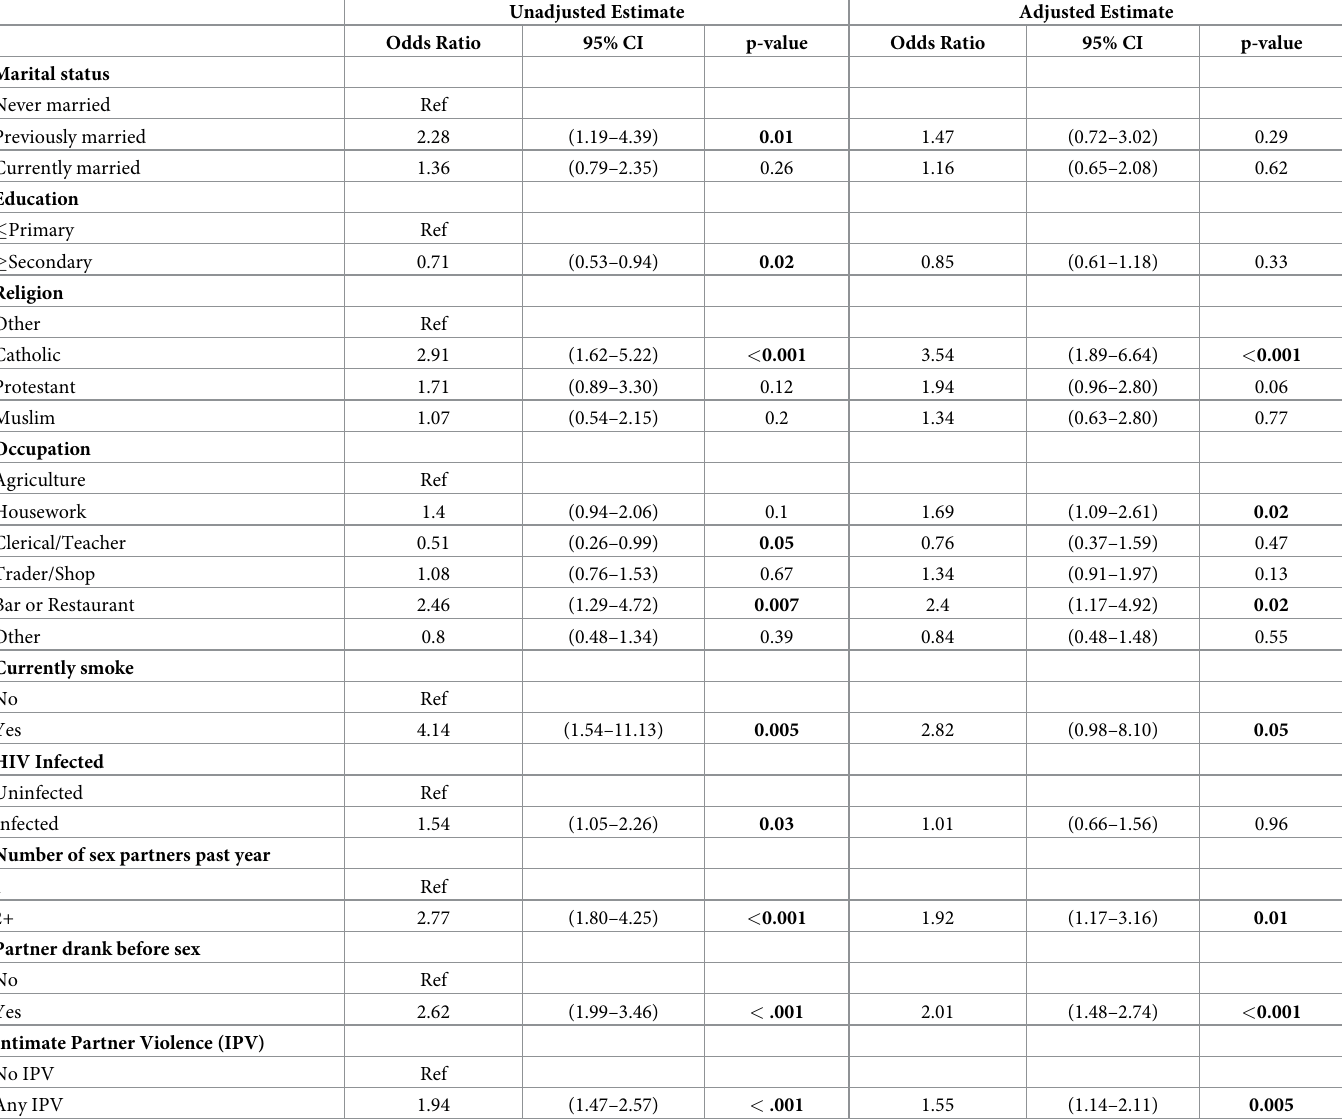
Table 2. Unadjusted and adjusted logistic regression models of correlates of alcohol use during pregnancy among participants in RCCS between March 2017 and September 2018. Unadjusted